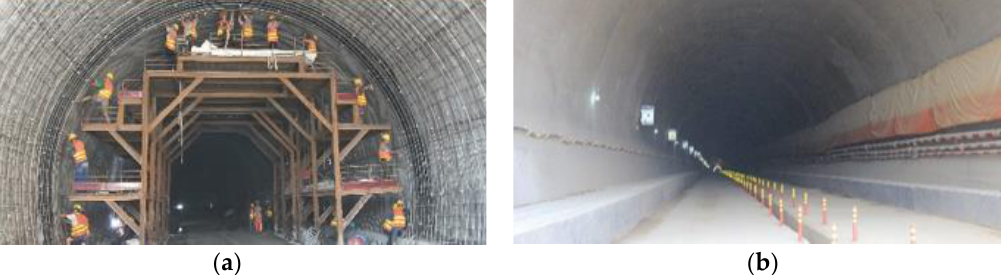
Figure 11. ( a ) Tunnel support construction and ( b ) tunnel after support. On-site condition of tunnel after support optimization.